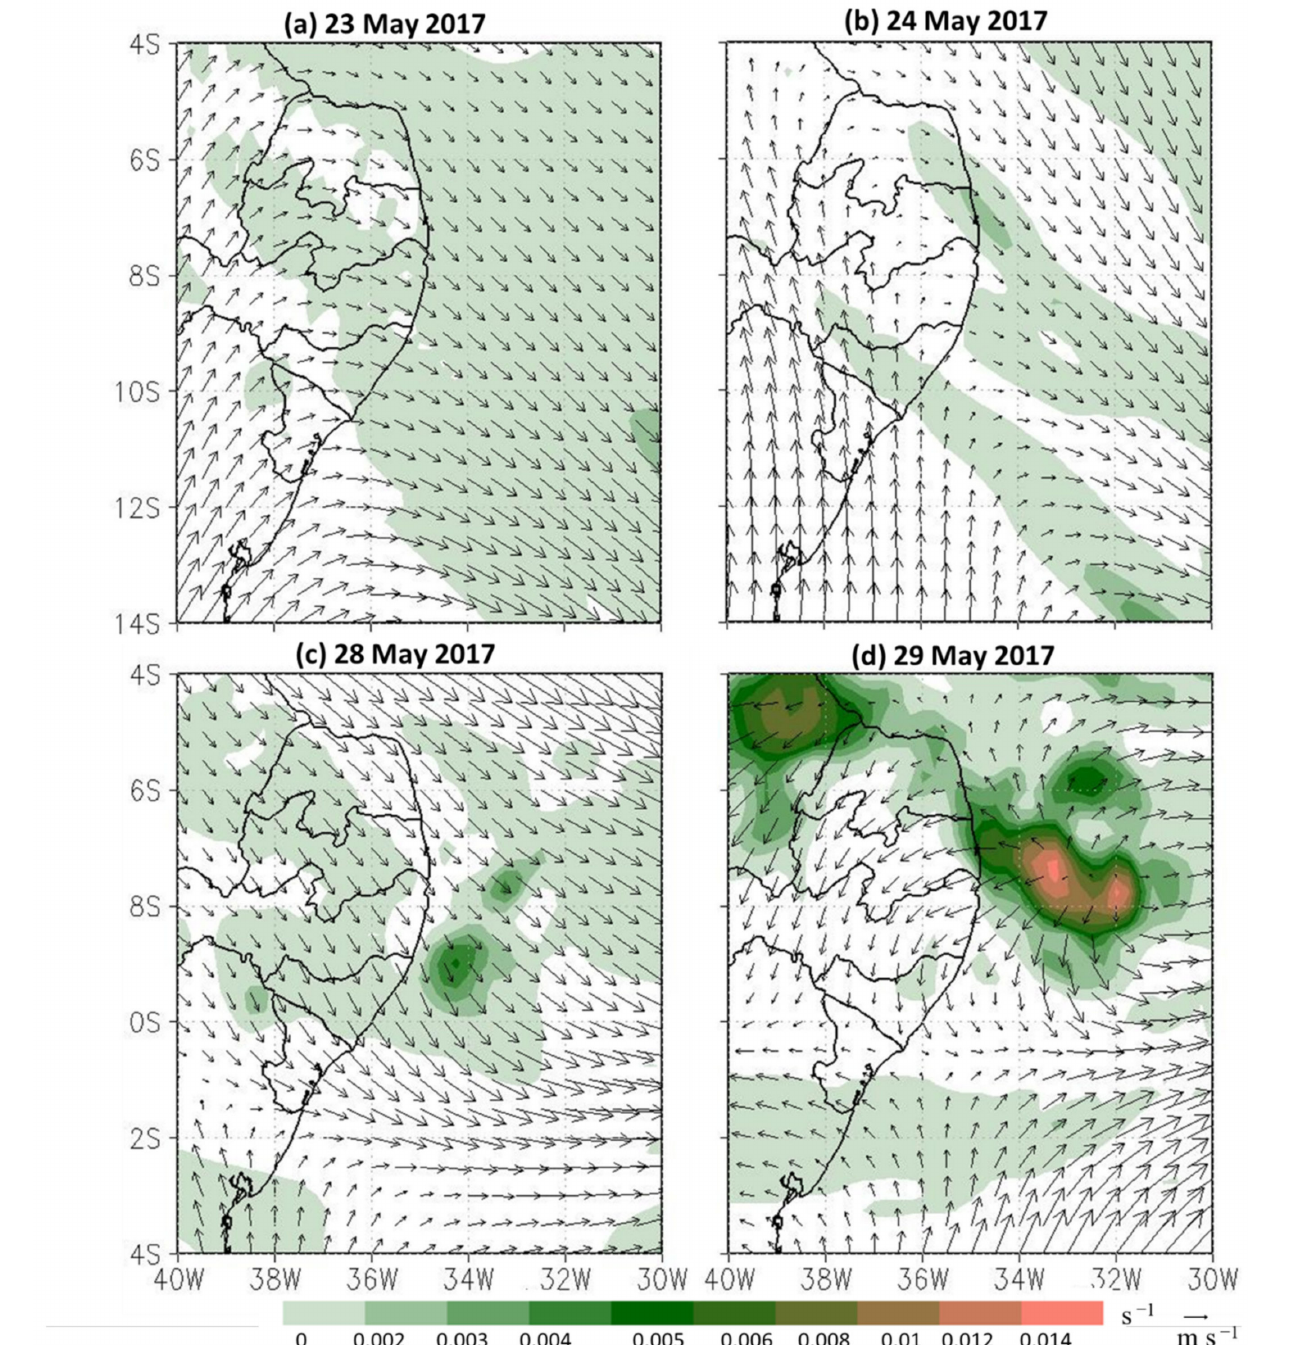
Figure 12. Average daily wind divergence fields (shaded) at the vertical level of 200 hPa (m s − 1 ) and wind flow in the current line at the level of 200 hPa. The information corresponds to 24 ( a ), 25 ( b ), 28 ( c ), and 29 ( d ) May